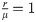
Estimated demographic history with seed banking.Estimated demographic history using four simulated sequences of 10 Mb and ten replicates under a saw-tooth demographic scenario (black). The mutation and recombination rates are set to 2.5 × 10−8 per generation per bp. Therefore rμ=1. We simulate under four different germination rates β = 1 (red), 0.5 (blue), 0.2 (green) and 0.1 (purple), hence we respectively have ρθ=1, = 0.5,0.2 and 0.1. The demographic history is estimated using a) eSMC, b) MSMC, c) MSMC2 and d) PSMC’. β* represents the estimated germination rate by eSMC.